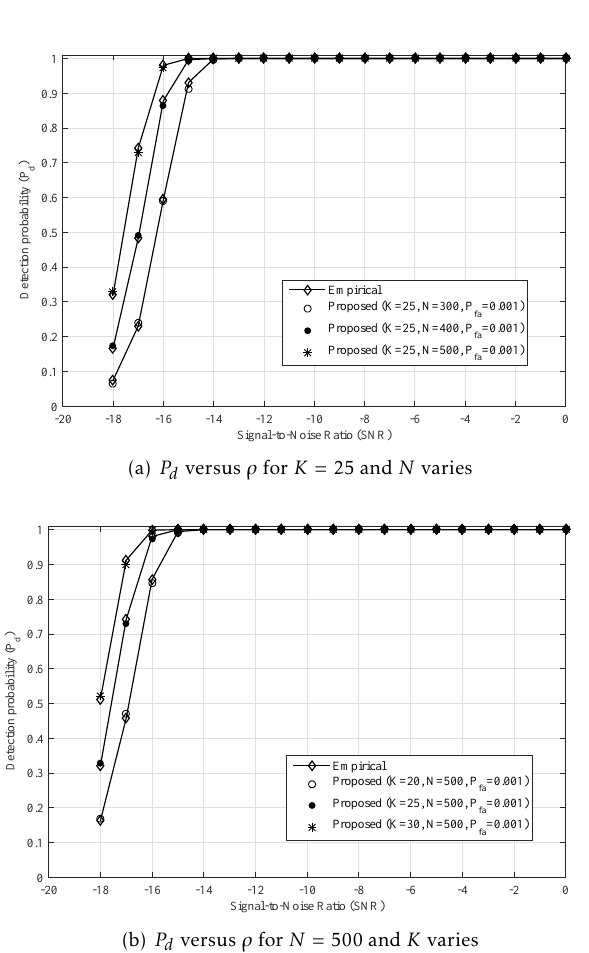
Figure 4. Empirical P of the SCN detector as a function of d SNR and its corresponding proposed approximation for different values of N and K with P f a = 0 . 001